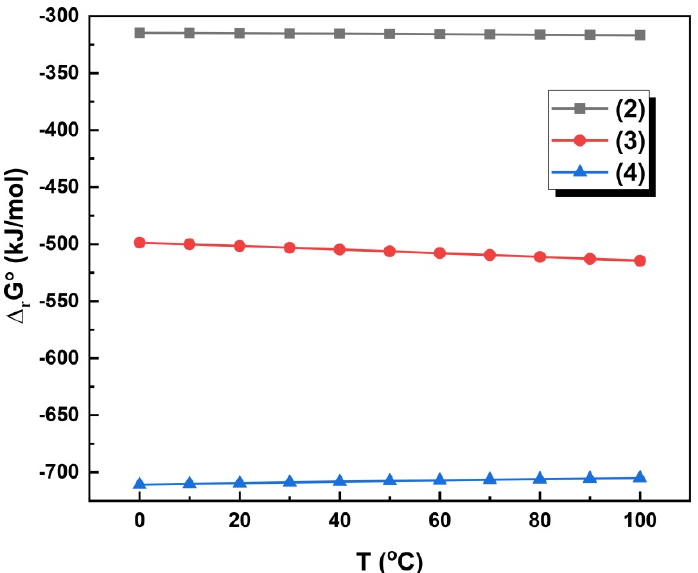
Figure 2. The plots of ΔrG°~T for the Equations (2)–(4) (Drawn by HSC 5.0 chemistry software, Outokumpu Research, Finland).